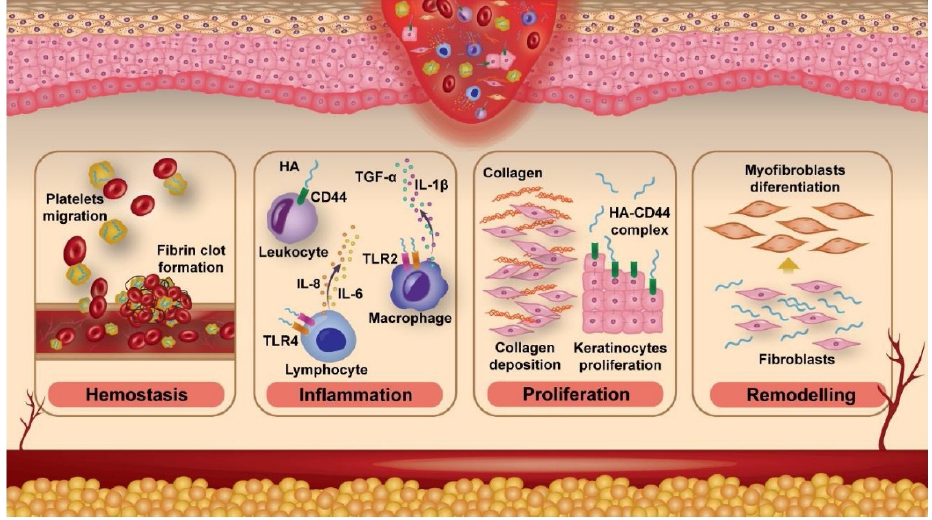
Figure 1. Involvement of hyaluronic acid in the wound-healing process. (Reprinted with permission from Ref. [18]. Copyright 2020 Elsevier.)